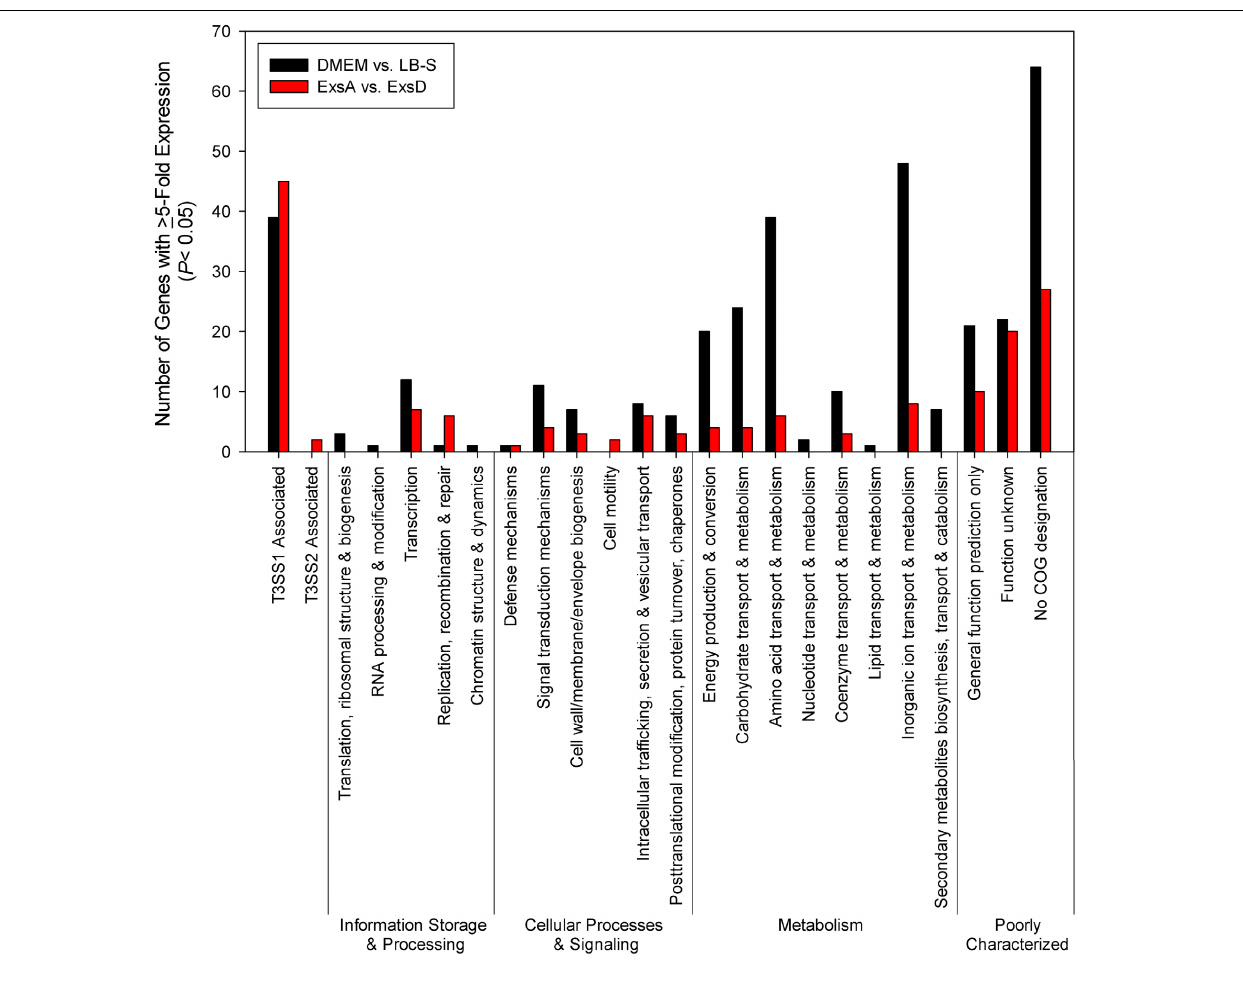
expression ( P < 0 . 05) and grouped by COG designation and association with T3SS1 ( vp1656 — vp1702 ; vpa0450 — vpa0451 ) or T3SS2 ( vpa1314—vpa1378